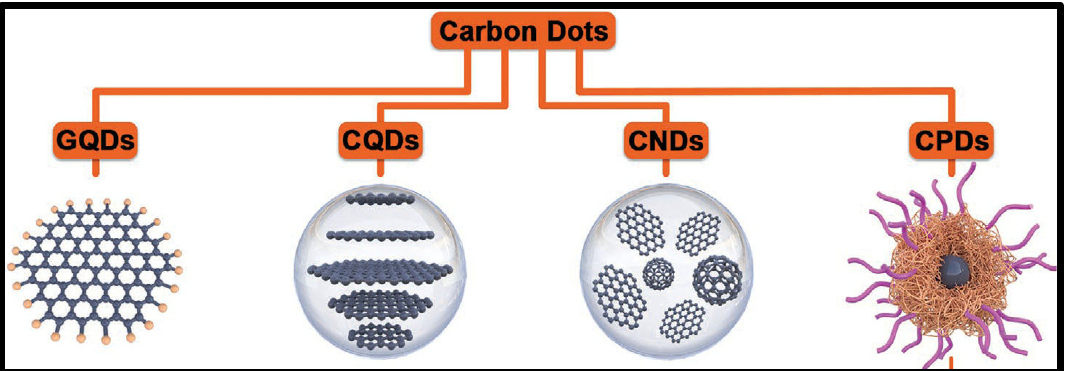
Figure 1. The proposed representative structures of a graphene quantum dot (GQD), carbon quantum dot (CQD), carbon nanodot (CND) and carbonized polymer dot (CPD). Adopted with permission from Wiley-VCH Verlag [12].